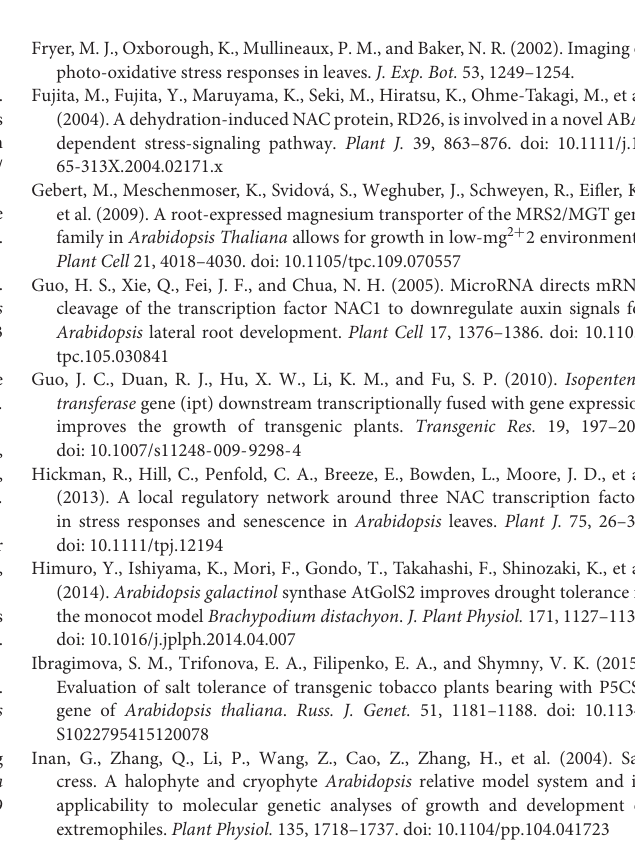
TABLE S1 | Some downstream-regulated genes by EsNAC1 in Arabidopsis . TABLE S2 | Candidate target genes of EsNAC1 in Arabidopsis . TABLE S3 | Primers used in this